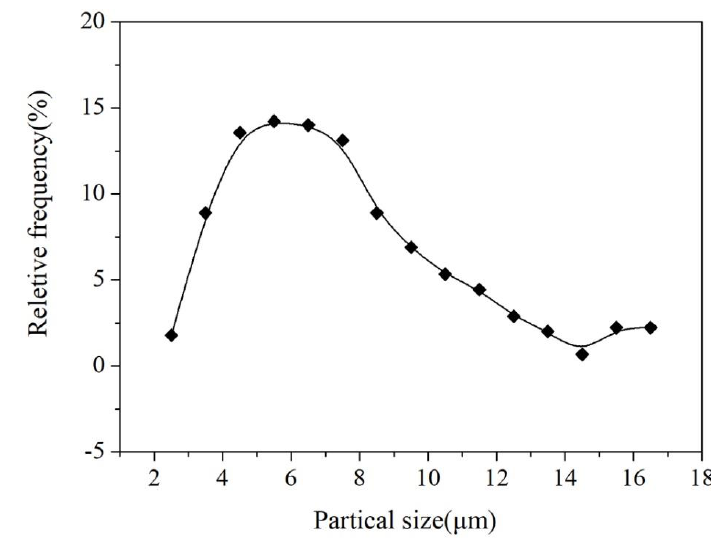
Figure 7. BSE-SEM images of the as-extruded YA65 alloy: ( a ) low magnification; ( b ) high magnification.